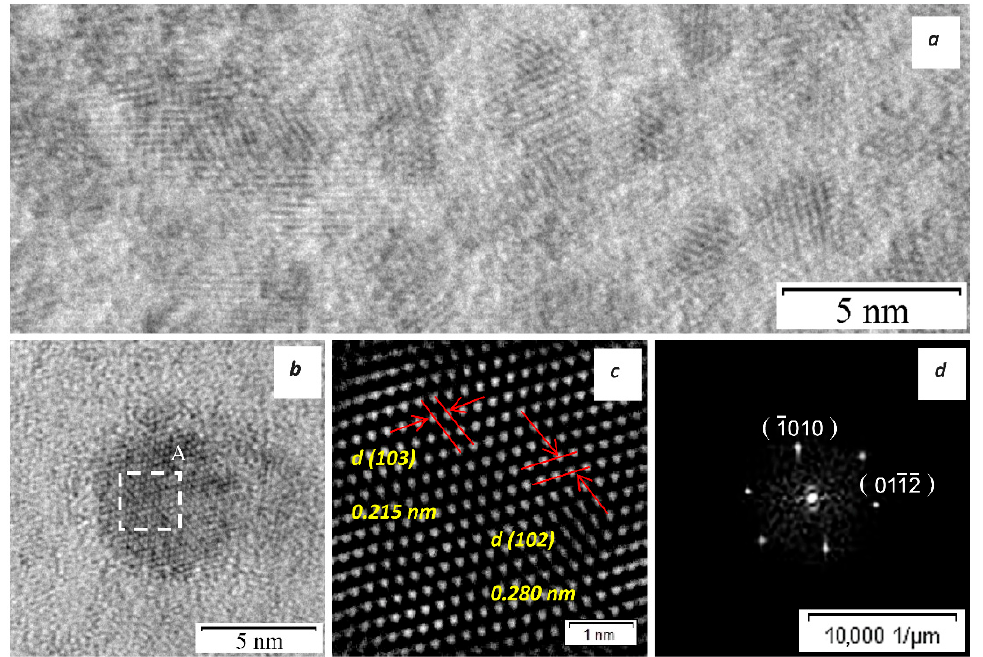
Figure 5. ( a ) The HRTEM image of the coating structure heated up to 800 ◦ C; ( b ) the [2423] HRTEM image of the Mo 2 Ni 3 Si phase pre-precipitate with corresponding IFFT ( c ) and FFT ( d ) patterns from region A.